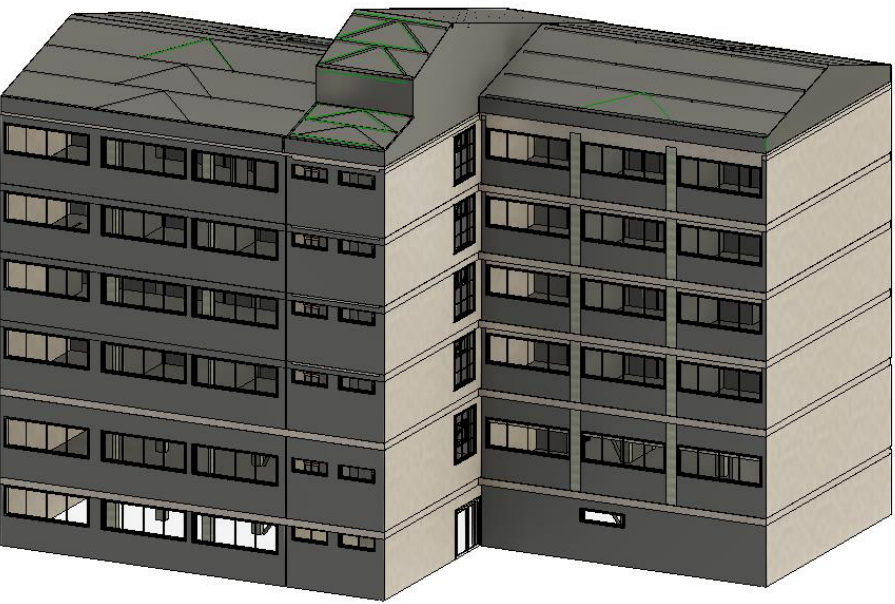
Figure 14. BIM model of the case study building.